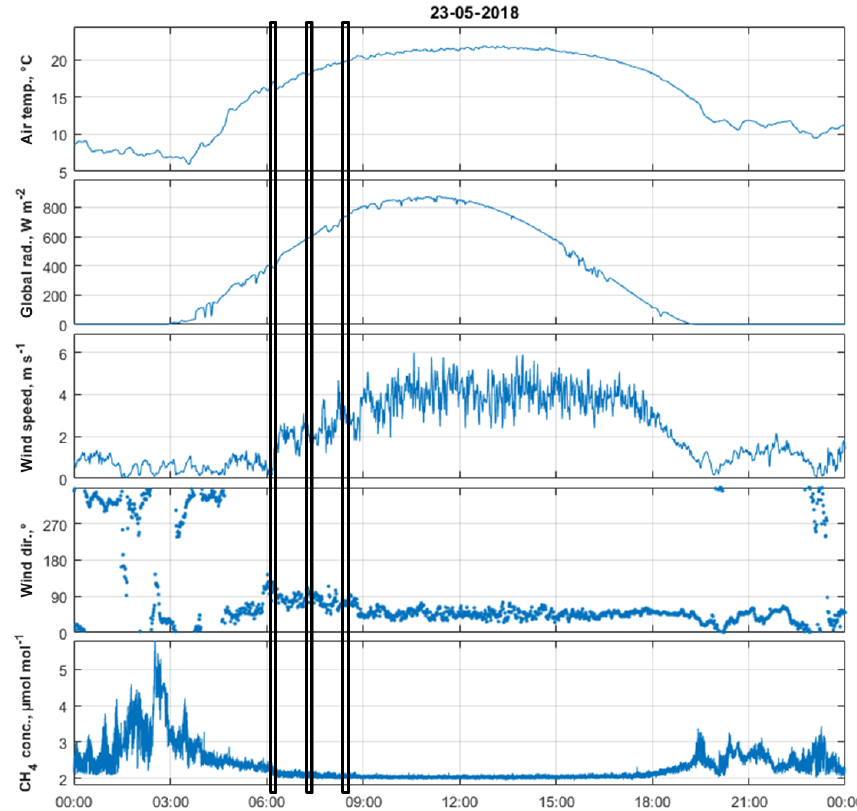
Figure 5. Diurnal course of the main meteorological parameters air temperature, global radiation, wind speed, wind direction and methane concentration (closed-path Los Gatos sensor) recorded at the meteorological mast at Zarnekow on 23 May 2018. The times of the quadro- copter air sampling are indicated by vertical